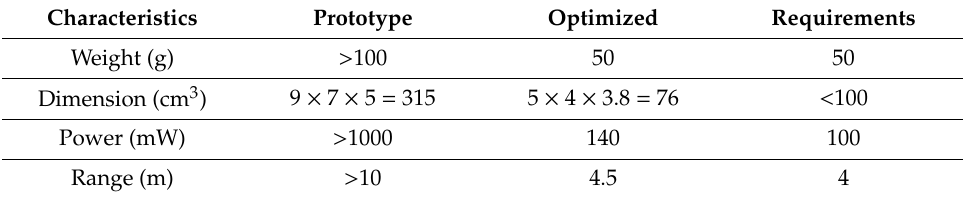
Table 5. Comparison between the prototype and the optimized module (depth camera) .